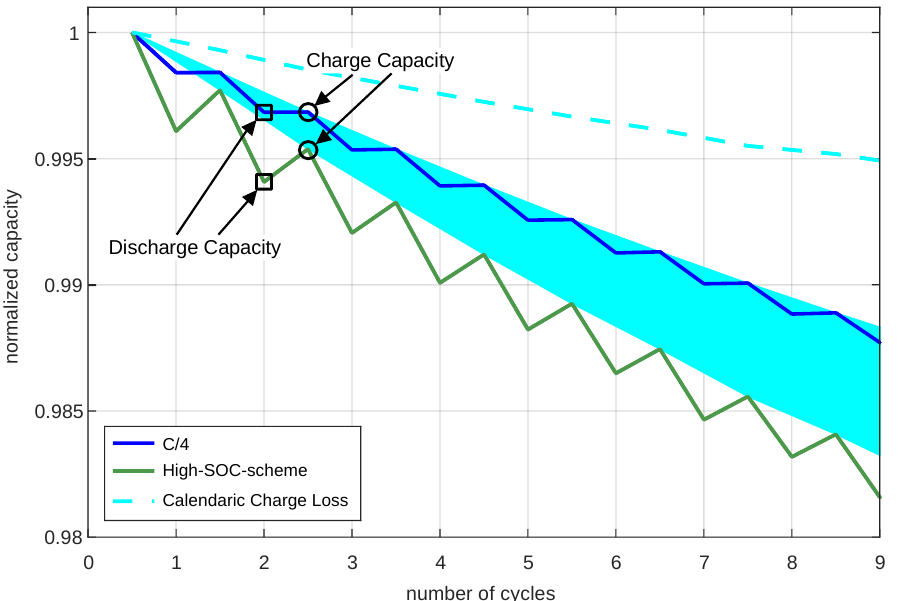
Figure 16. The blue and green curves show the capacity degradation of the C/4-measurement and the high-SoC-scheme-measurement. The cyan-colored area marks the difference between C/x-scheme and high-SoC-scheme due to the calendrical aging of the high-SoC-scheme. The cyan dashed line represents the calendrical aging rate alone. It is legitimate to compare the high-SoC-scheme with the C/4 measurement of the C/x-scheme, as no calendrical aging occurred in the C/x-scheme measurements anyway, as shown in Section